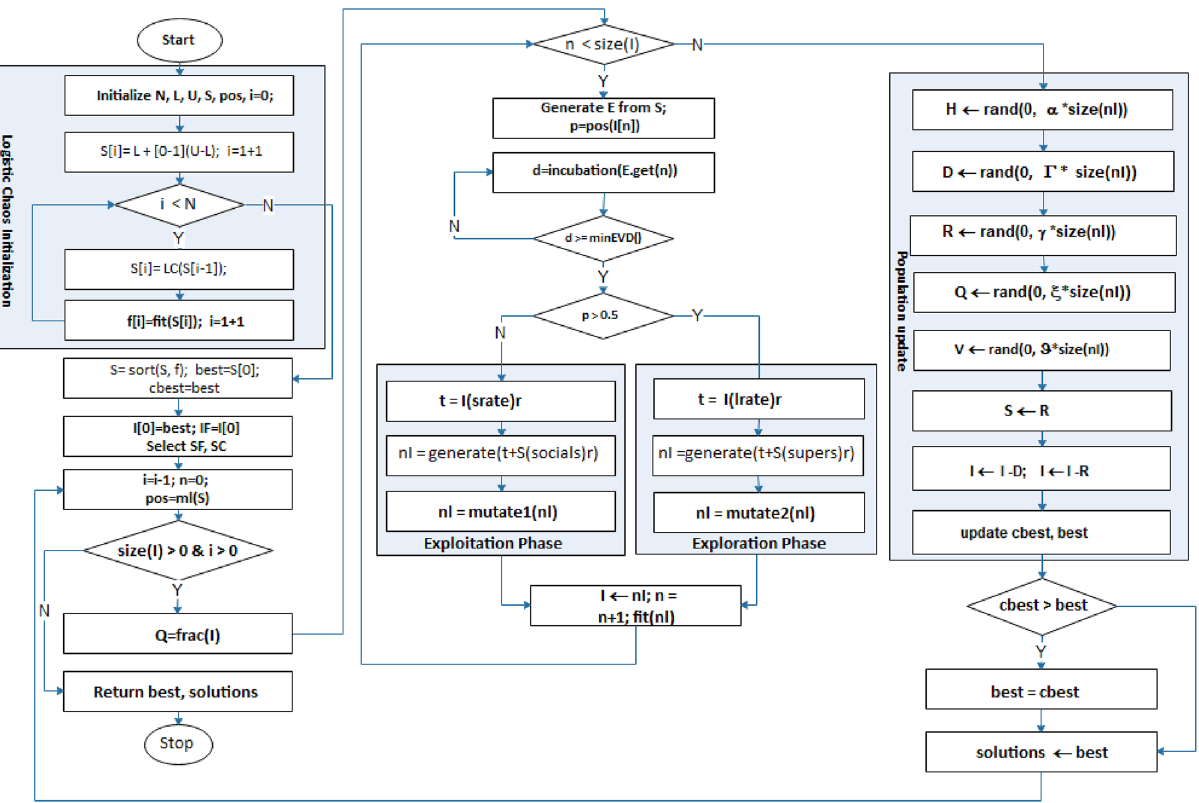
Figure 2. Flowchart demonstrating the optimization process of the improved IEOSA from the initialization and search process to the return of the best solution obtained during the